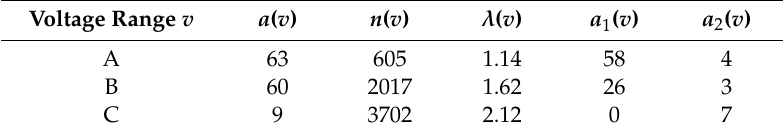
Table 3. Characterization of overloaded lines in the N condition by voltage range.